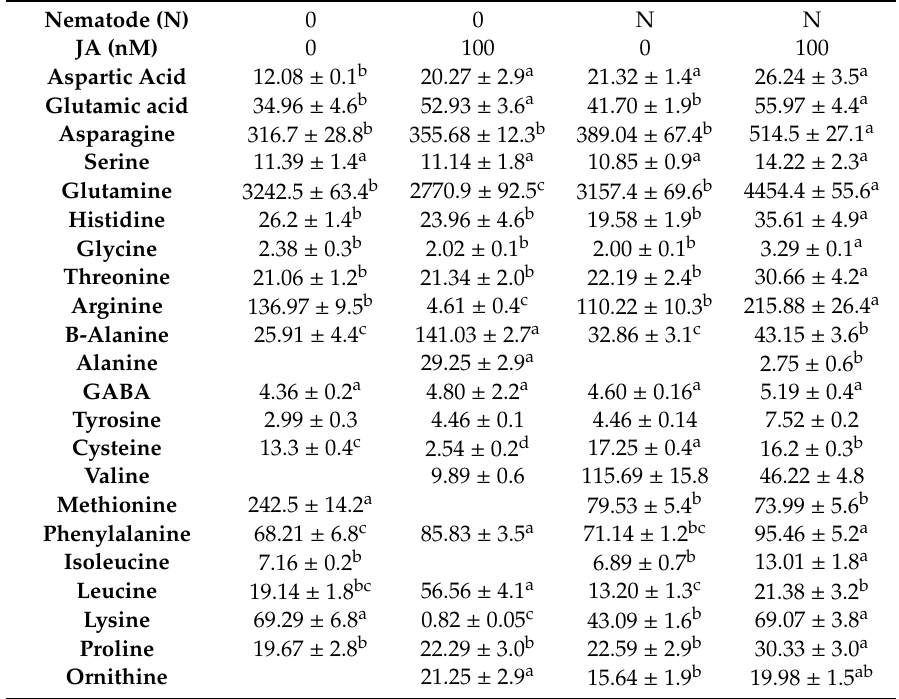
Table 4. E ff ect of seed soaking treatment of JA (100 nM) on amino acid profiling ( µ g g − 1 FW) in tomato seedlings after seven days of nematode